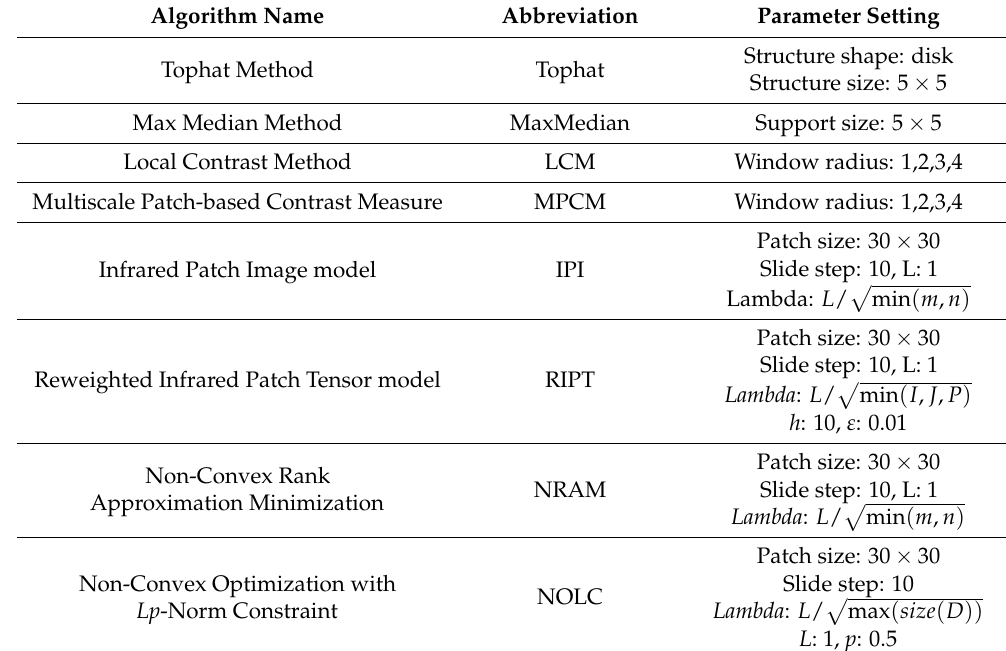
Table 1. Algorithm parameter setting.